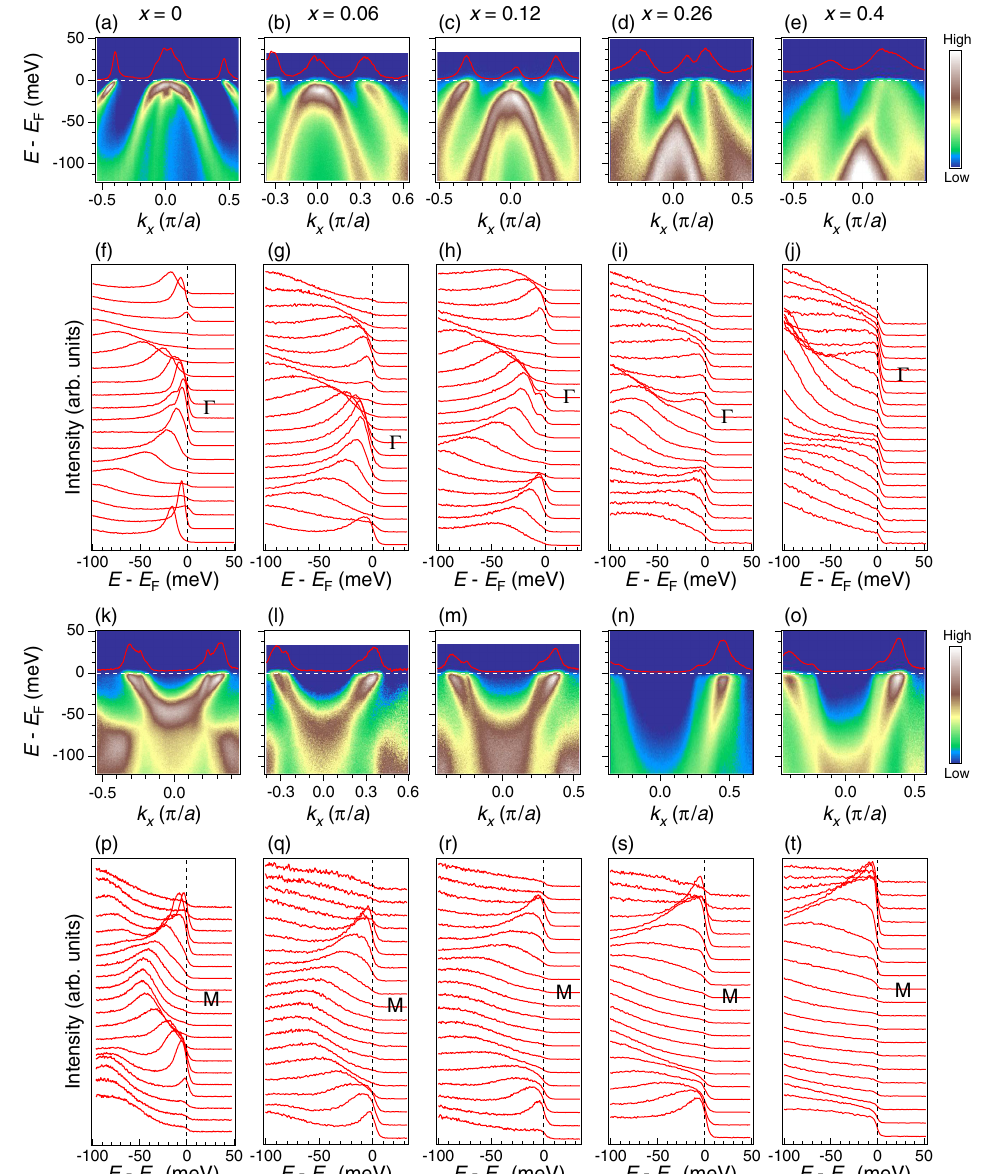
FIG. 9. (a) – (j) ARPES intensity plots and corresponding EDCs at the Brillouin zone center. (k) – (t) ARPES intensity plots and corresponding EDCs at the M point. All data are taken at 20 K along the Γ - M direction. The red curves shown in the intensity plots are MDCs at the Fermi